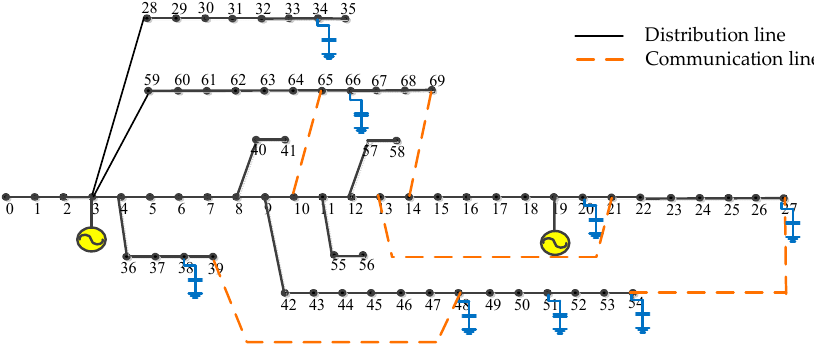
Figure 3. The diagram for the modified IEEE 69-bus test system.